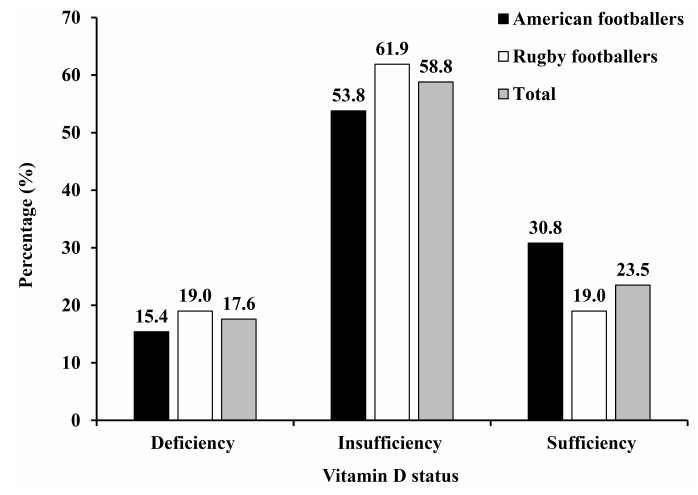
Figure 1. Prevalence of vitamin D deficiency and insufficiency.